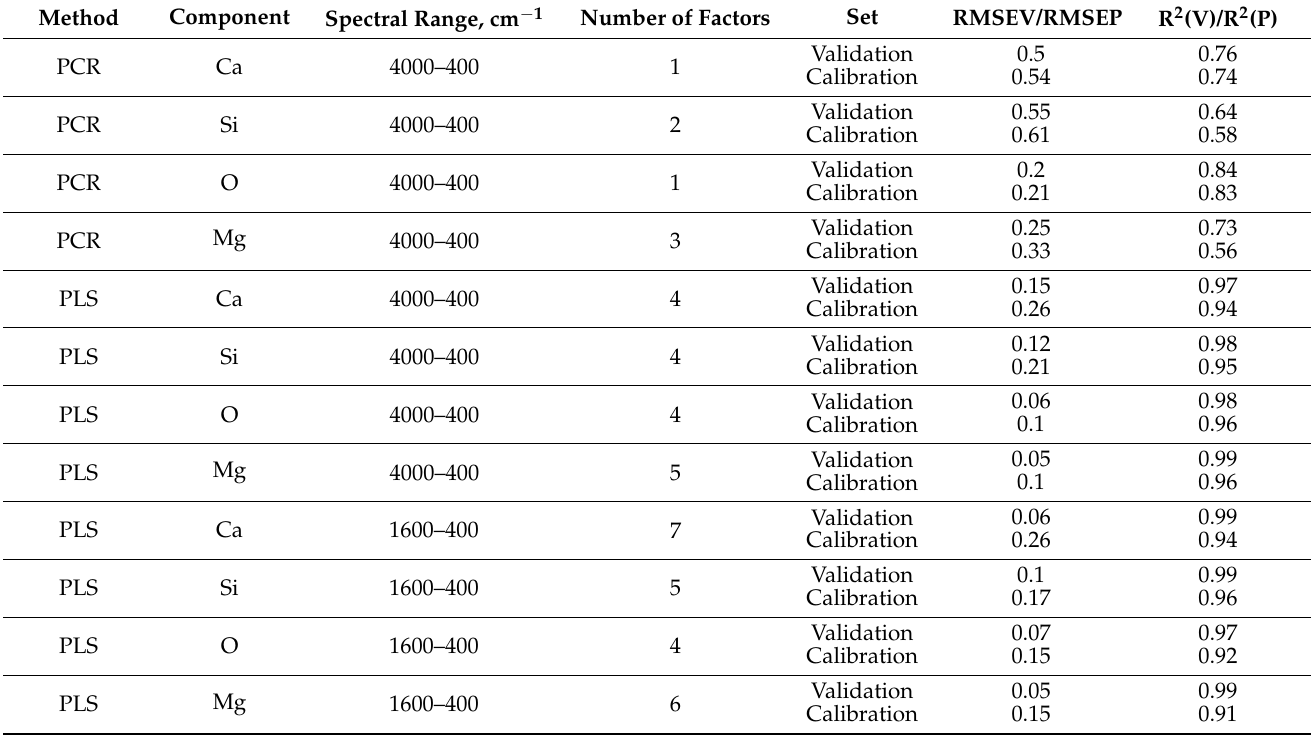
Table 6. Verification of the quality and accuracy of calibration models for determining the components of the composition of granulated blast furnace